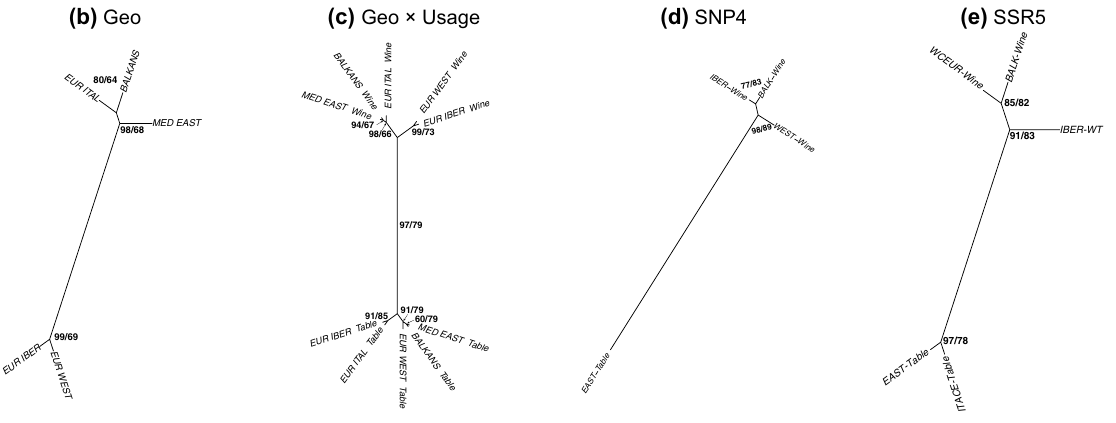
Figure 1. Unrooted trees obtained with hierarchical clustering of the form of pips (length + shape) grouped according to covariates of interest. For each node the numbers correspond to pvclust/cross-validation values. Tree ( a ) corresponding to use, as a two-class case has no topology and is not